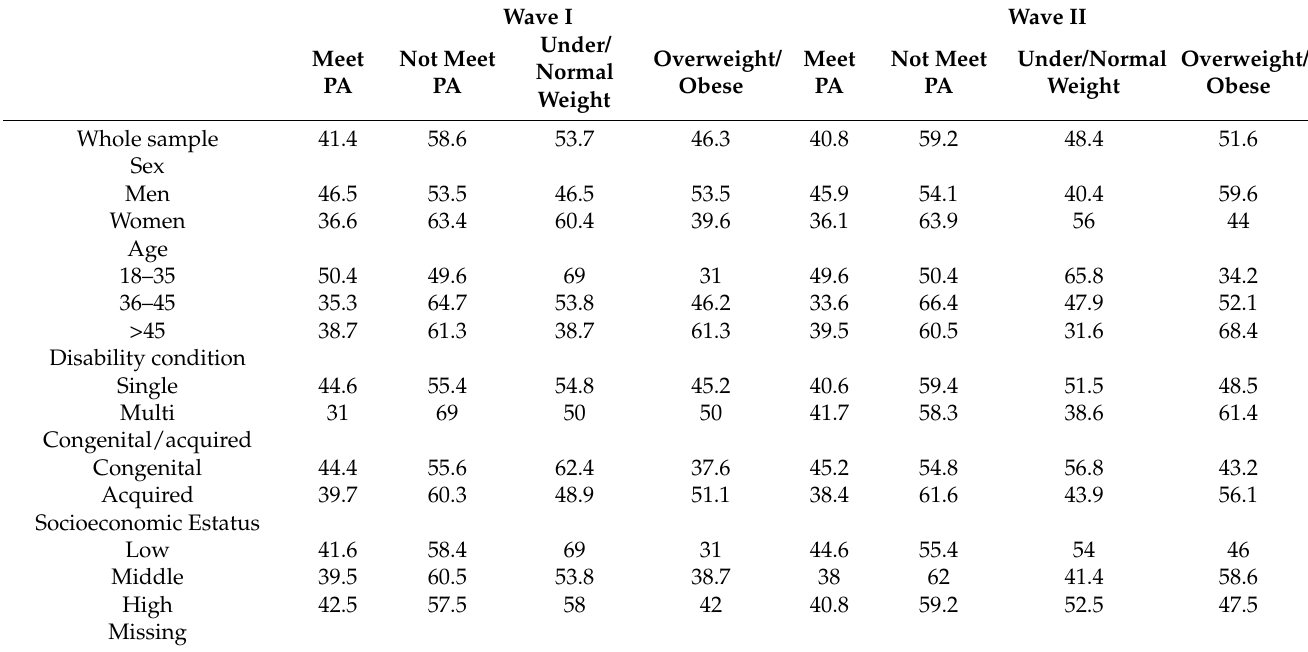
Table 4. Percentages of participants’ accomplishment of WHO’s PA recommendations and their weight status by wave and individual characteristics ( n =